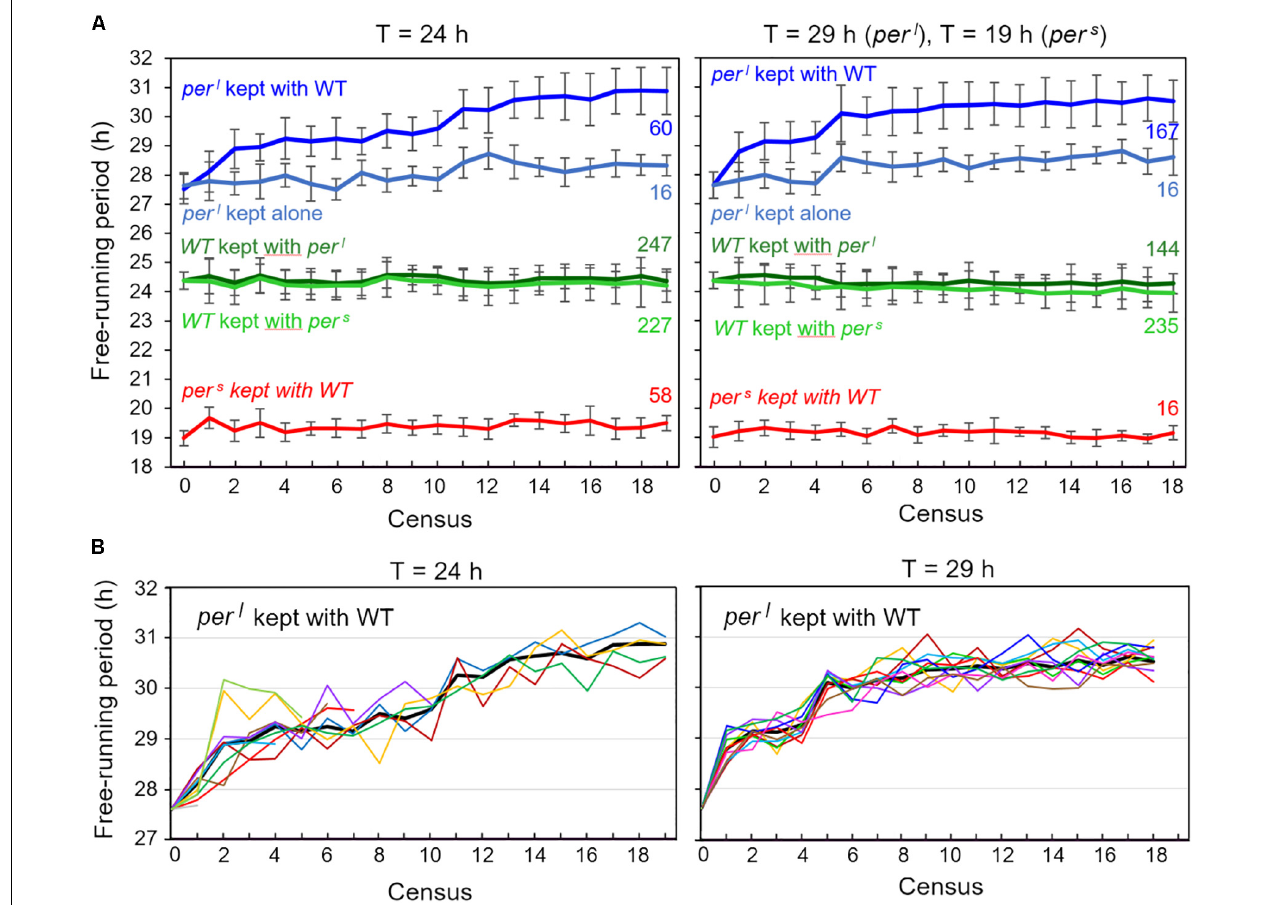
FIGURE 9 | Free-running periods of the flies recorded during the two competition experiments [at Zeitgeber cycles (T) of 24 h (left) and T = 29 h or T = 19 h (right)]. Every census, 32 flies of each of the 10 vials with the competing genotypes ( per l /WT, per s /WT) were recorded in DD (= 4 × 320 flies per census, see Figure 2 ) and the flies‘ free-running periods determined and plotted (mean of all flies from all 10 vials ± SD) (A) . The experiment started with equal numbers ( ∼ 160 at census 1) for each genotype and ended with a lower number of mutants, except for per l mutants kept under T = 29 h (right diagram). The numbers at the right margin give the number of individuals for each genotype at the last census (19 under T = 24 h and 18 under T = 19 /29 h). In case of per s the flies included in the determination of period stem only from few vials (3 under T = 24 h, and 1 under T = 19 h). In case of per l , the number of vials was larger (4 under T = 24 h, and 10 under T = 29 h). Wildtype flies were present in all 10 vials, except for the competition experiment with per l mutants under T = 29 h. Here the calculated periods at census 18 stem from flies in 8 vials. Note that the sum of mutants and WT flies is always lower than 320, because some flies died during the recording. The pale blue curve give the mean period of per l mutants that were kept separately (not in competition with wildtype flies under the same environmental conditions as the experimental animals) and that were recorded in parallel to the other flies (16 flies per census). While the per l mutants grown in competition with WT flies lengthened their period by ∼ 3 h, the ones kept separately did so only by < 1 h (B) . Period lengthening of per l mutants over the course of the competition studies in the single fly vials at T = 24 h and T = 29 h. The mean free-running periods of the flies for each of the 10 vials are shown as colored lines. The thick black line shows the average period of all flies that is also depicted in A . At T = 24 h, per l mutants persisted only in 4 vials until the end of the experiment. Therefore, six colored lines ended before census 19. This is different at T = 29 h, where per l mutants persisted in all 10 fly vials (compare Figure 7